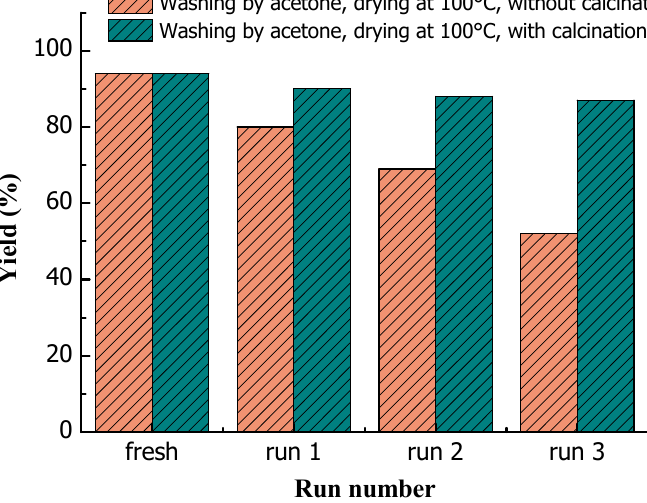
Figure 8. Recyclability and regeneration study of Na 2 CaP 2 O 7 in the synthesis of 5a .